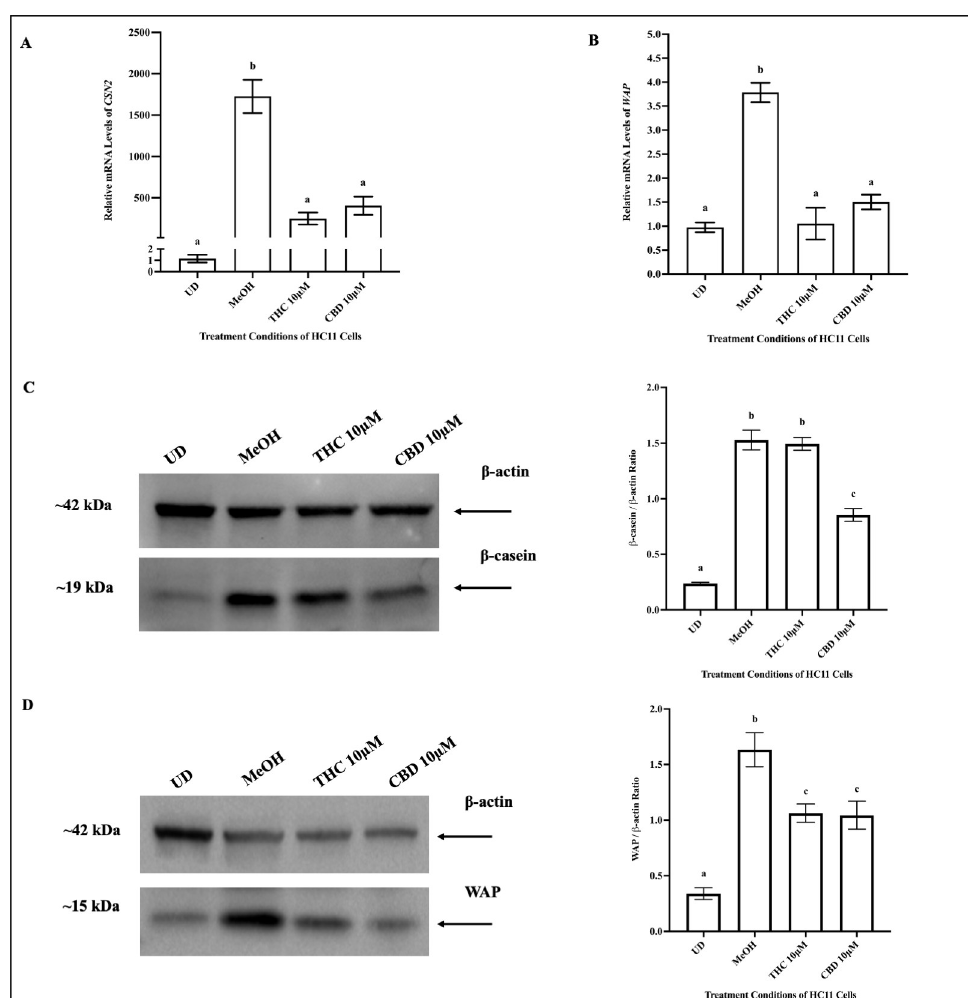
Fig 4. 10 μ M THC and 10 μ M CBD reduced levels of milk proteins in HC11 cells. HC11 cells were seeded in base media for 24 hours (UD) and processed for total RNA or protein, as described in the methods. HC11 cells were differentiated in base media containing PRL, INS and DEX, as described in methods, and treated with vehicle control (MeOH), 10 μ M THC or 10 μ M CBD for 4 days, and processed for total RNA or protein. The relative mRNA levels of CSN2 (A) and WAP (B) were determined. Gene expression analysis was repeated with 6 distinct replicates. Milk protein expression was assessed, as described in the methods, using 15 μ g of total protein for each sample. Representative blots of β -casein (C) and WAP (B) are shown along with a bar graph quantifying the protein expression, normalized to β -actin, for undifferentiated cells (UD), vehicle control (MeOH), 10 μ M THC and 10 μ M CBD treated HC11 cells, based on 4 replicates. Results were plotted as mean ± SEM and compared using one-way ANOVA. Statistically significant changes were represented by distinct